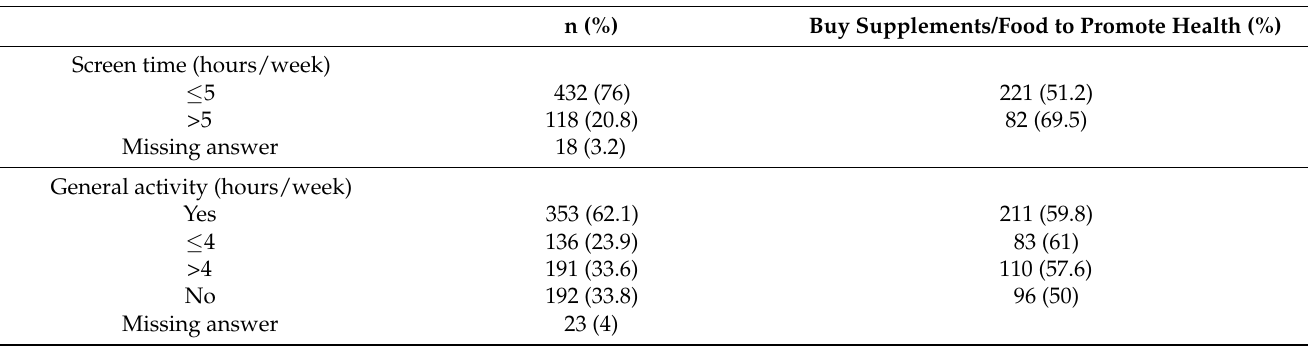
Table 2. Screen time and physical